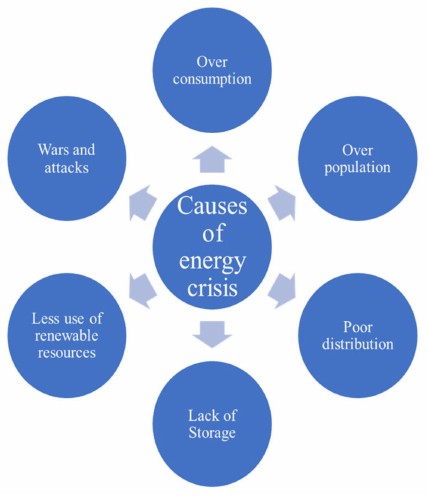
Figure 4. Causes of energy problems in developing countries.